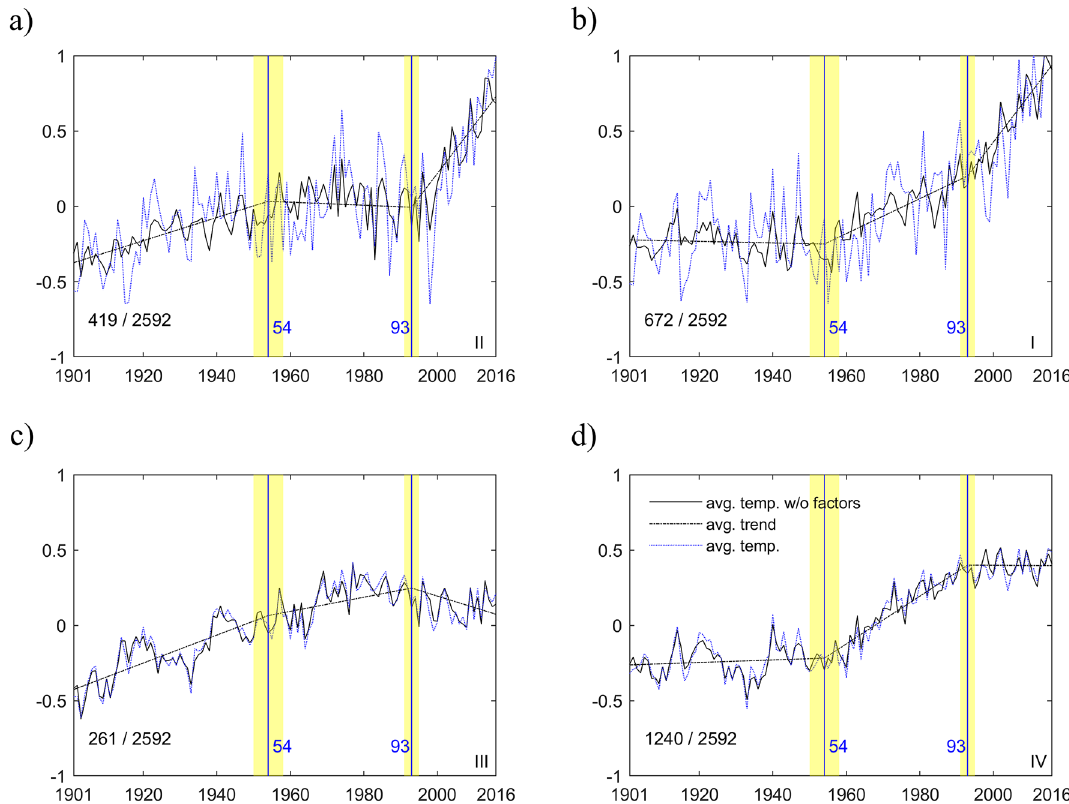
Figure 2. Average annual warming trends. The dash-dot line in each panel shows the average trend for each of cases I ~ IV in Fig. 1. ( a – d ) Denote the cases II, I, III and IV, respectively. The dotted line is the average of annual temperatures and the solid line is the average of annual temperatures without the common factor part ( f ′ t (cid:31) i ). The two vertical lines indicate the estimated break dates with the shaded interval being the asymptotic 95% confidence intervals. The fraction in the bottom left corner of each panel shows the number of series for each